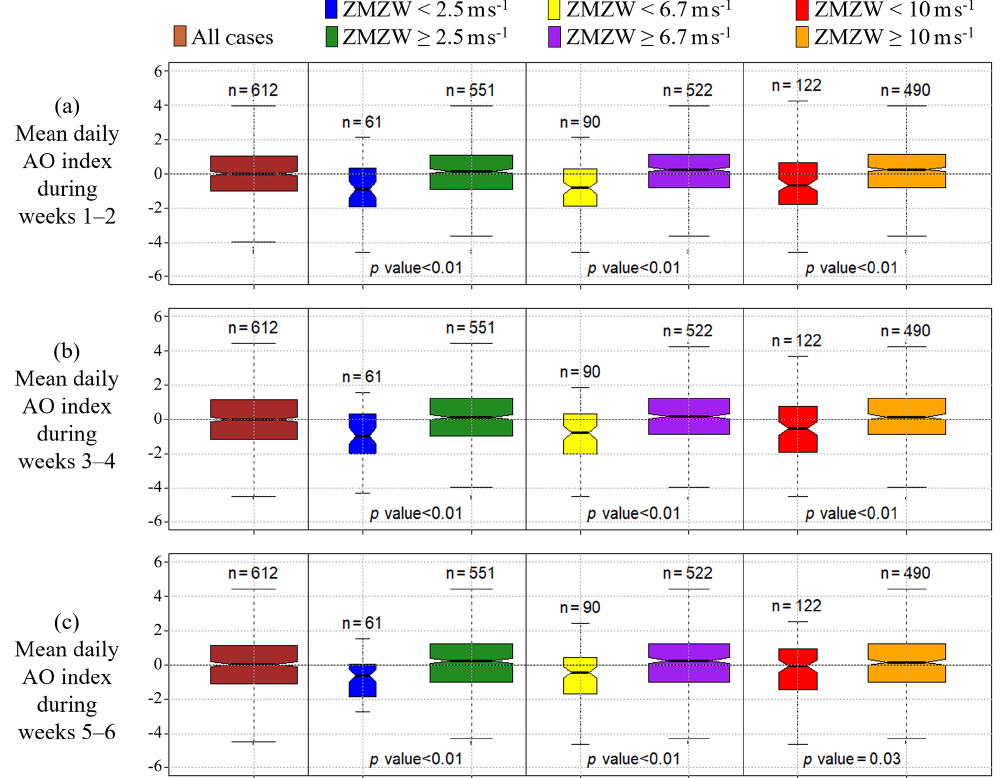
Figure 2. Observed mean AO index in November–March (1981–2016; a) 1–2, (b) 3–4, and (c) 5–6 weeks after different thresholds of the zonal mean zonal wind (ZMZW) at 60 ◦ N and 10hPa. The horizontal line dividing each box into two parts shows the median of the data, the ends of the box show the lower and upper quartiles, and the whiskers represent the highest and the lowest values, excluding outliers. The n written above each box indicates the number of observations in each group. The p value written below each boxplot pair indicates the likelihood of such a pair of distributions arising from a random sampling of a single distribution, as given by a Student’s t test; i.e. p values less than 0.01 indicate that the means of the data sets differ significantly at the 99% level of confidence. The notches of each side of the boxes were calculated by R boxplot.stats. If the notches of two plots do not overlap, then this is strong evidence that the two medians differ (Chambers et al.,